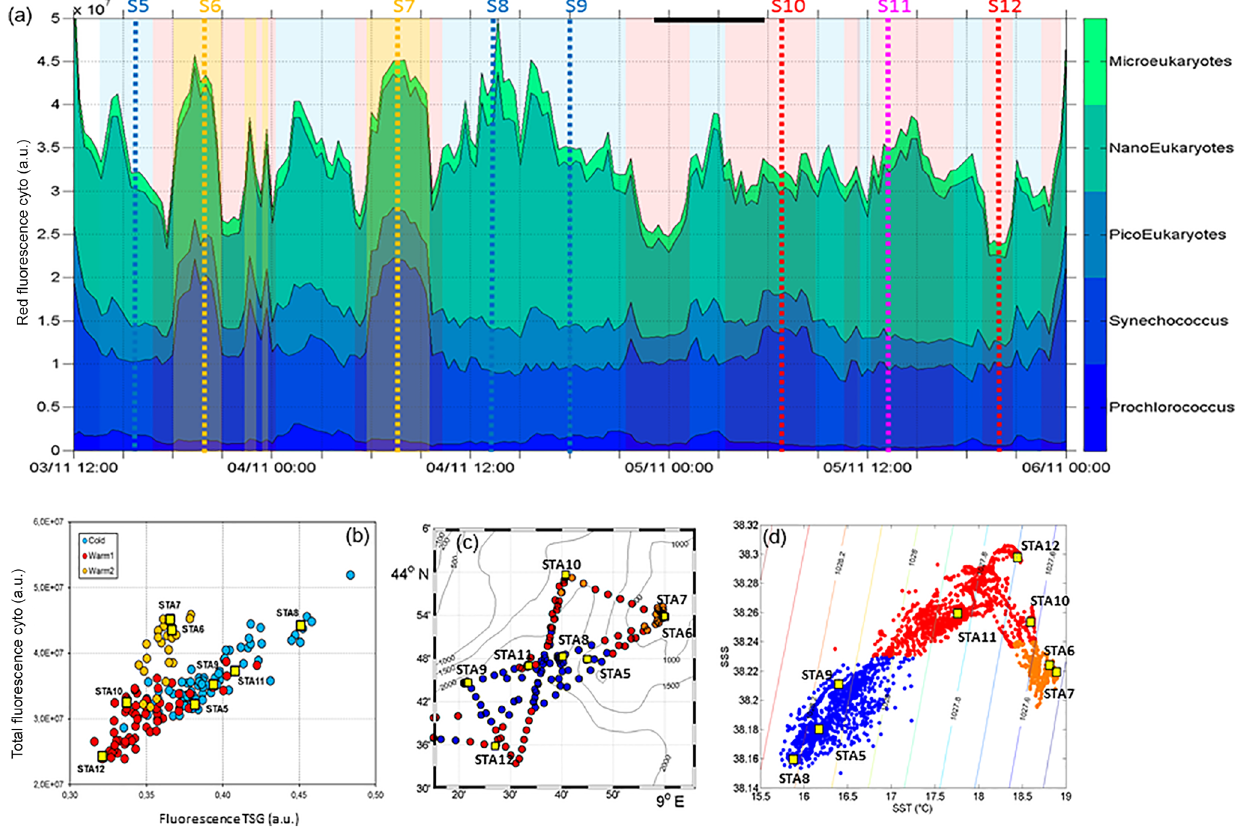
Figure 7. (a) Relative contribution FLR i = ( FLR m,i · Abundance i ) of Prochlorococcus , Synechococcus , picoeukaryotes (PicoE + PicoHighFLR + PicoHighFLO), nanoeukaryotes (NanoE + NanoFLO + NanoHighFLO) and microeukaryotes (Mi- croE + MicroHighFLO) to the integrated red fluorescence signal (FLR Total = P i ( FLR m,i · Abundance i )) from 3 November 12:00 to 6 November 00:00. Vertical dashed lines represent sampling times of the eight fixed stations (STA5 to STA12) performed during the campaign and colors correspond to the type of surface waters in which stations were performed. (b) Fluorescence recorded with the FLRTotal (in a.u.) vs. TSG (in a.u.) recorded by the automated flow cytometer. Blue, red and orange dots correspond to sampling performed in cold core, warm boundary 1 and boundary 2 surface waters. (c) Sampling positions of automated flow cytometry surface measurements. Blue, red and orange dots correspond to sampling performed in cold core, warm boundary 1 and boundary 2 surface waters. (d) SSS vs. SST (in ◦ C) plot from continuous TSG measurements with corresponding density isolines. The distinction between cold core and warm boundary 1 and 2 surface waters throughout the paper was made according to this